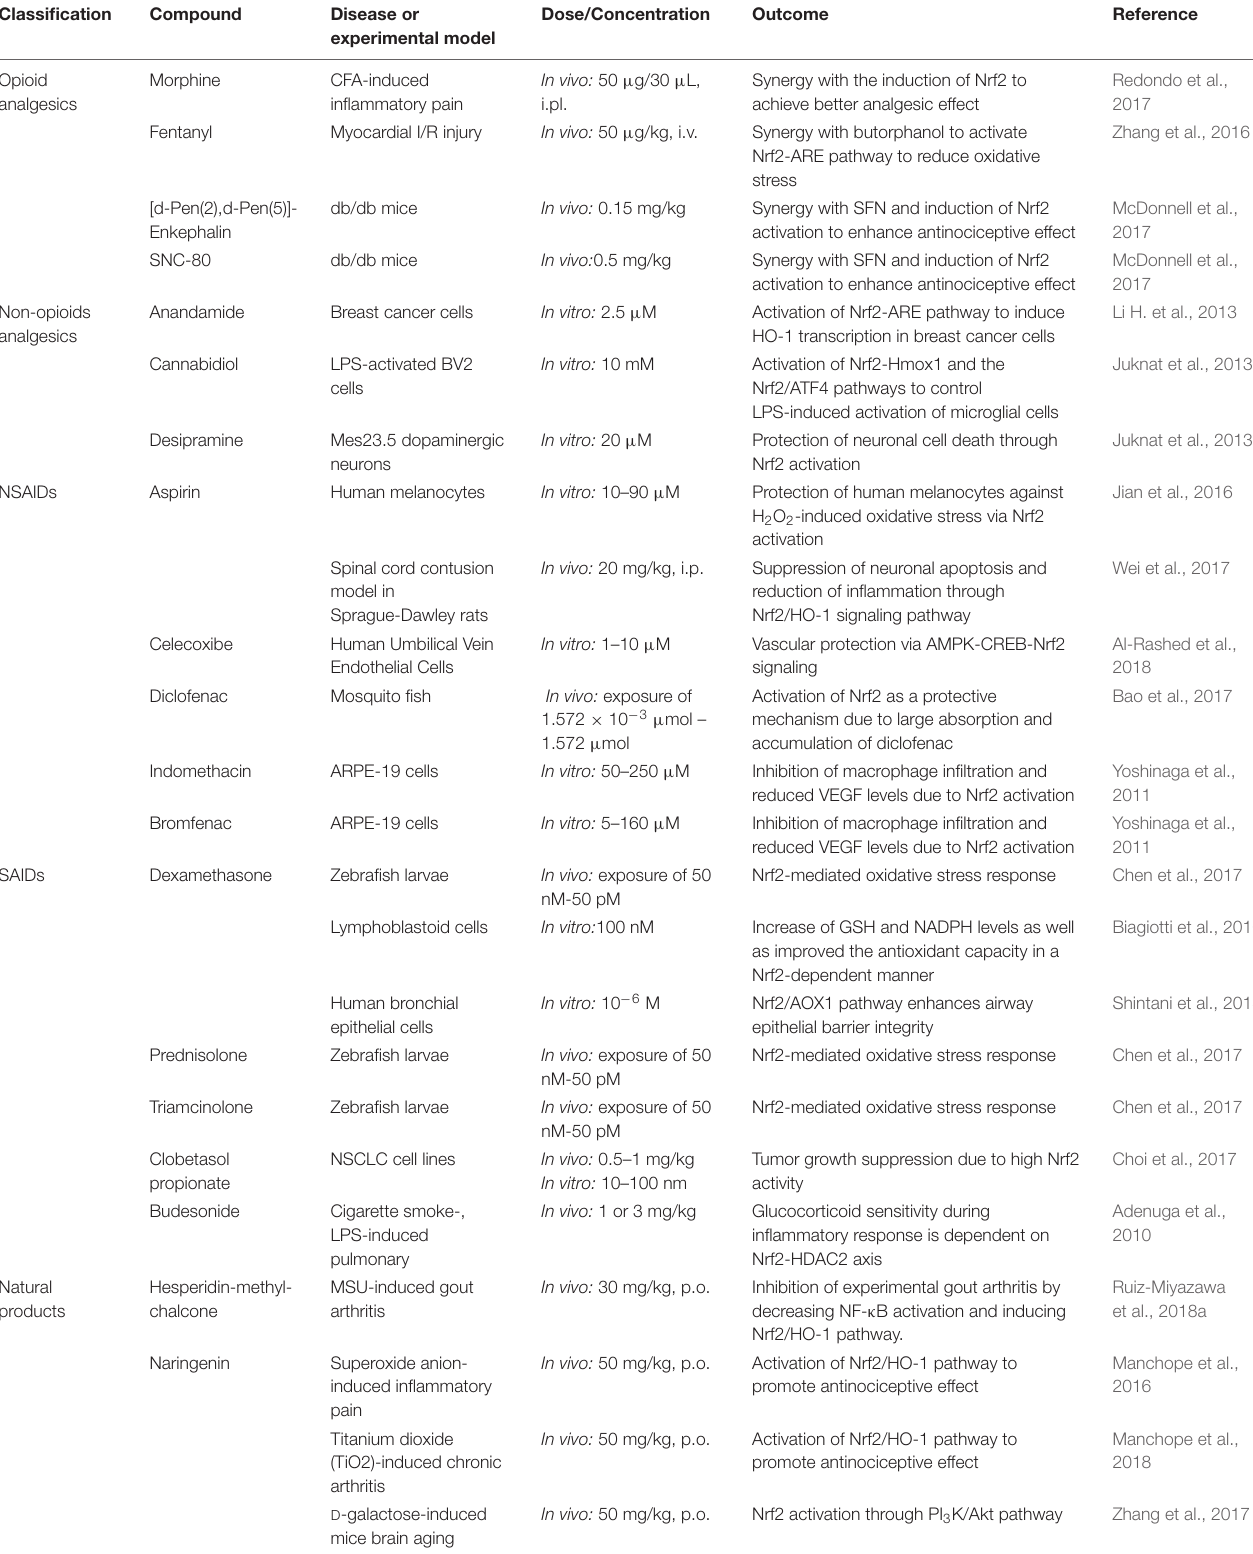
TABLE 1 | Summary of evidence on analgesic and anti-inflammatory drugs that modulate